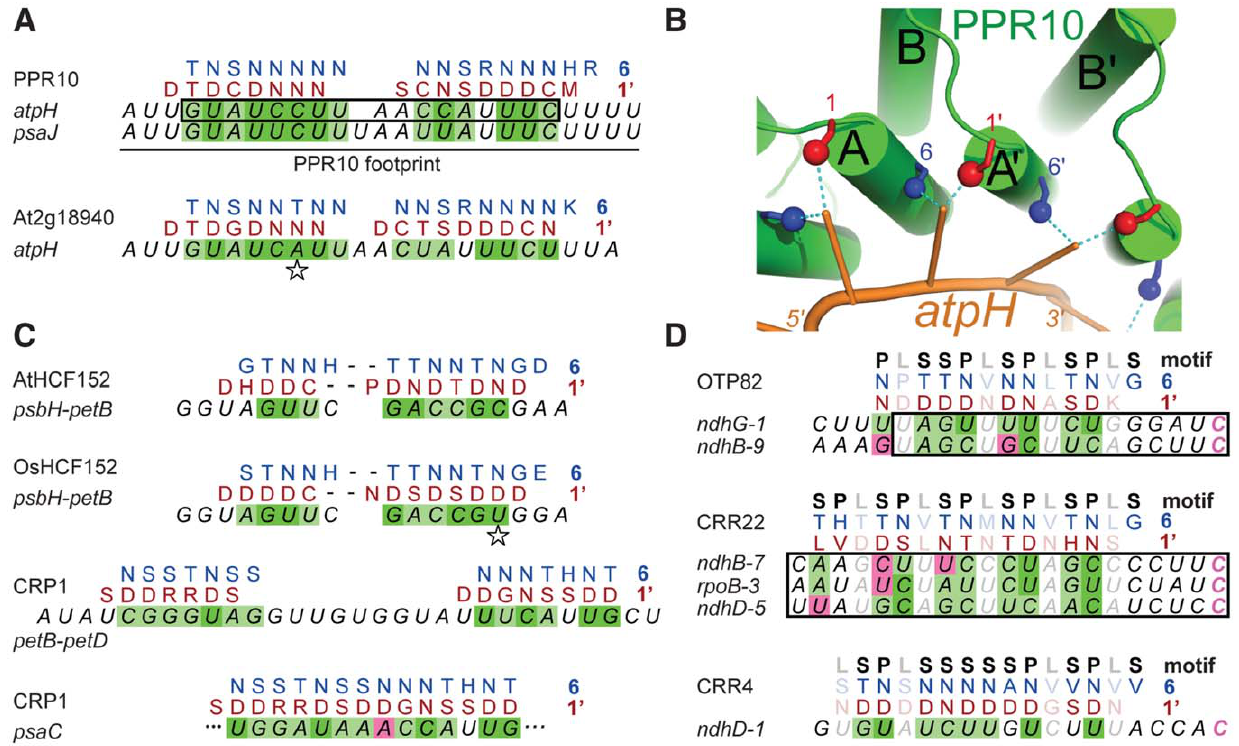
Figure 2. Alignments between PPR Proteins and Cognate Binding Sites. (A) Statistically optimal alignments between amino acids at positions 6 (blue) and 1 9 (red) in PPR10’s PPR motifs and its RNA ligands (italics). PPR10’s in vivo footprints are shown at top; the box marks the minimal binding site defined in vitro . Dark green shading indicates experimentally validated matches (Figure 5). Light green shading indicates significant correlation between position 6 and the purine/pyrimidine class of the matched nucleotide (Table S3). Magenta shading indicates significant anti-correlation between position 6 and the purine/pyrimidine class of the matched nucleotide (Table S3). Compensatory changes in orthologous protein/RNA pairs are indicated with a star. The PPR motifs are ordered from N to C terminus in the protein, and nucleotides are ordered from 5 9 to 3 9 in the RNA. The same schemes apply to panels (C) and (D). (B) Structural model illustrating physical plausibility of the cooperation between amino acids at positions 6 and 1 9 in nucleotide specification. The model of the PPR10- atpH RNA complex was produced using distance geometry methods as previously described [10]. RNA bases were constrained to be within 3 A˚ of residues 6 and 1 9 of helices A and A 9 of adjacent motifs. Each PPR motif consists of one ‘‘A’’ and one ‘‘B’’ helix, as marked. (C) Alignments between amino acids at positions 6 and 1 9 in PPR motifs of HCF152 and CRP1 and their RNA ligands. The psbH-petB sequence is HCF152’s in vivo footprint [17], within which HCF152 binds in vitro [16]. The petB- petD sequence is a CRP1-dependent in vivo footprint [16]. The psaC sequence maps within the 70-nt region that most strongly coimmunoprecipitates with CRP1 [19]. (D) Alignments between amino acids at positions 6 and 1 9 in PPR motifs of the RNA editing factors OTP82, CRR22 and CRR4 and their RNA targets [14,29]. Minimal binding sites determined in vitro are boxed. The edited C (magenta) is the last nucleotide in each case. The type of PPR motif, either P, L or S, is indicated above. Only matches involving P or S motifs are shaded, as L motifs cannot be accommodated within the code developed